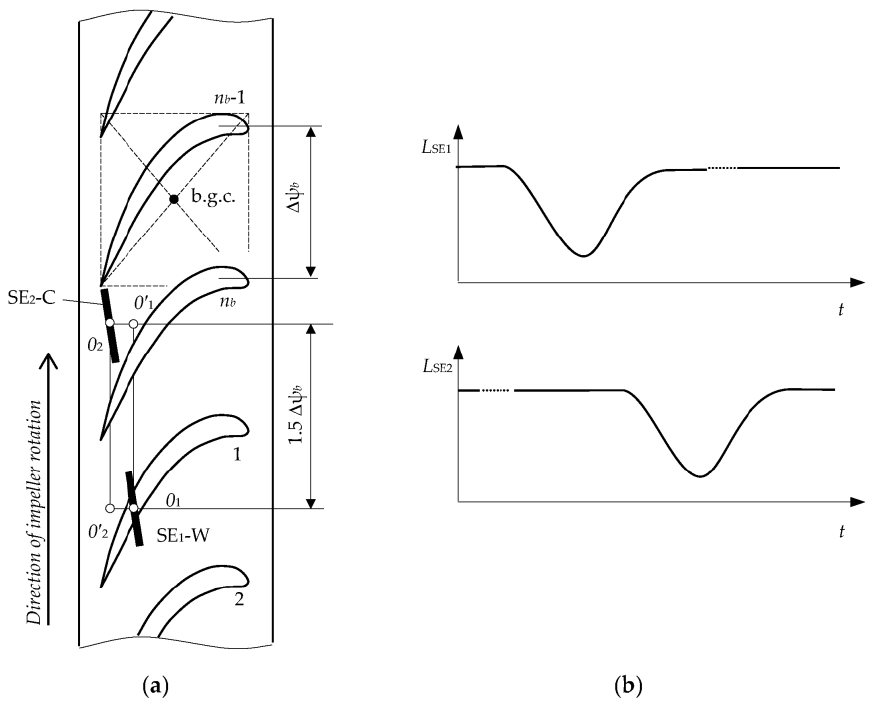
Figure 8. Method 1 : placement of the “distributed cluster” of SCECS on a turbine stator ( a ) and sensors’ SE inductance changes in time ( b ).